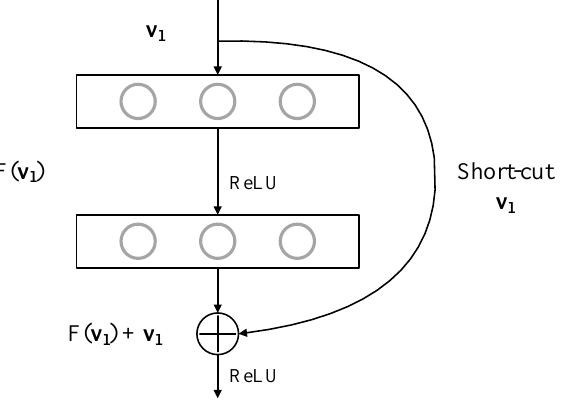
Figure 3. The structure for the residual